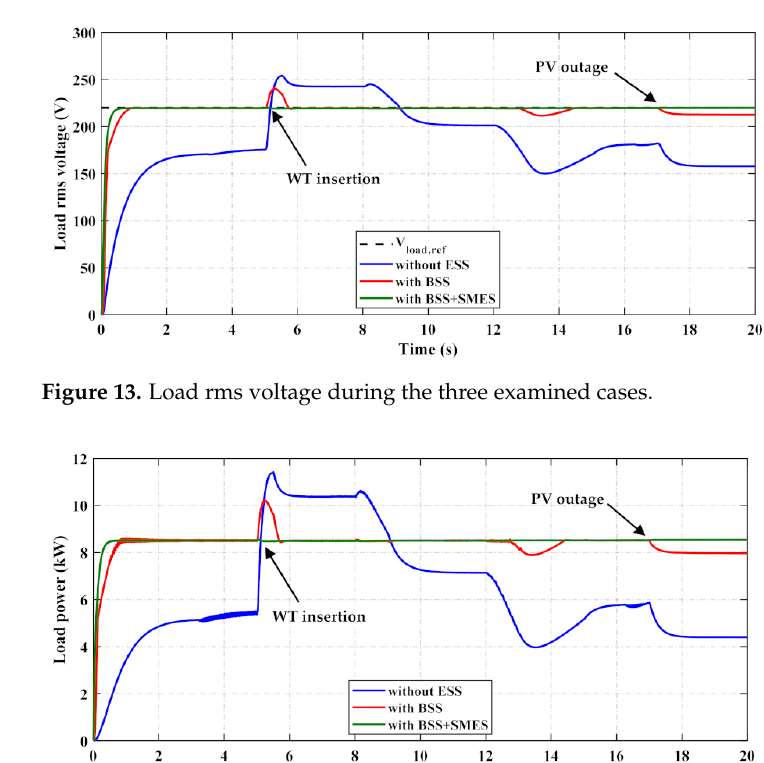
Figure 12. DC bus voltage during the three examined cases.